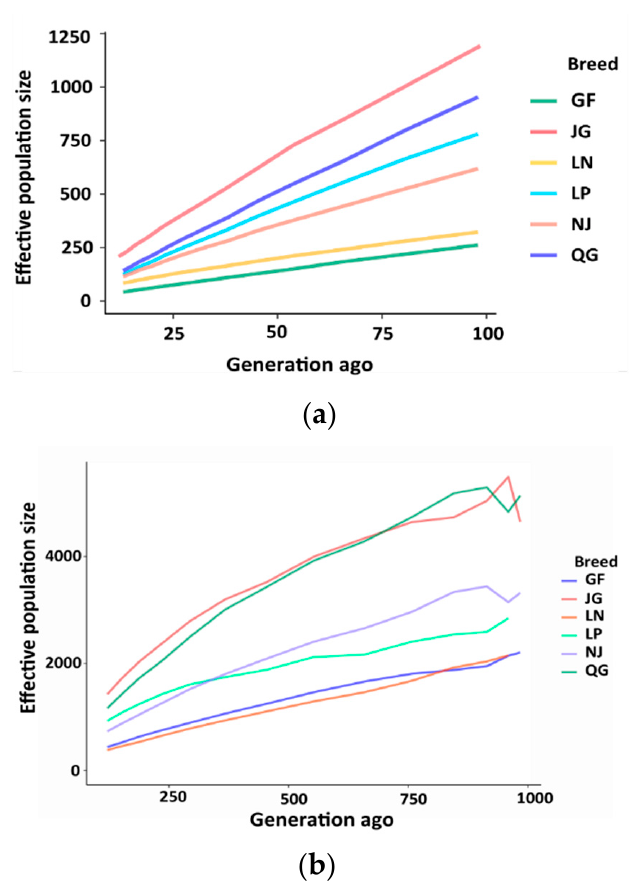
Figure 10. Estimated effective population sizes ( N e ) in six Chinese goat populations. ( a ) N e in the past 100 generations. ( b ) N e over the past 1000 generations.